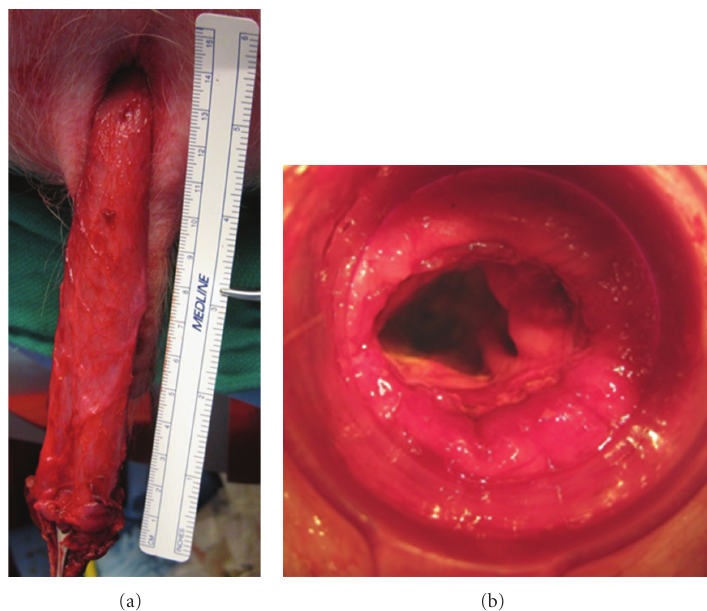
Figure 1: (a) Tranasanal extraction of specimen following completely NOTES in a swine survival model. (b) Intact stapled coloanal anastomosis following specimen